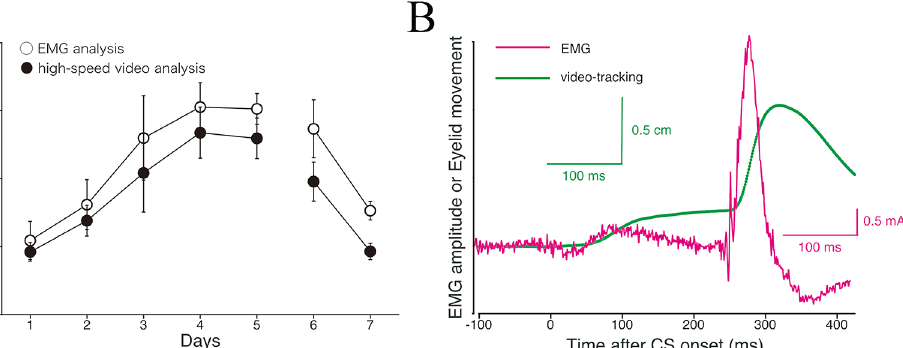
Fig 6. A comparison of the sensitivity of CR detection between EMG analysis and high-speed video analysis. (A) The all-subjects ( n = 5) day-by-day average CR% is compared between the EMG and video-tracking channels. (B) Comparison of CR response timing analyzed by these two methods. The averaged EMG amplitude and video-recorded movement of the eyelid are compared in a single graph.